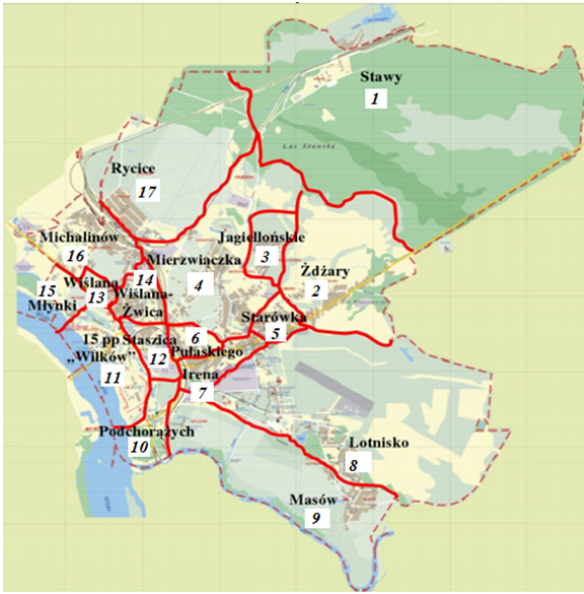
Figure 9: Graphical route separation for a city cleaning vehicle [33]